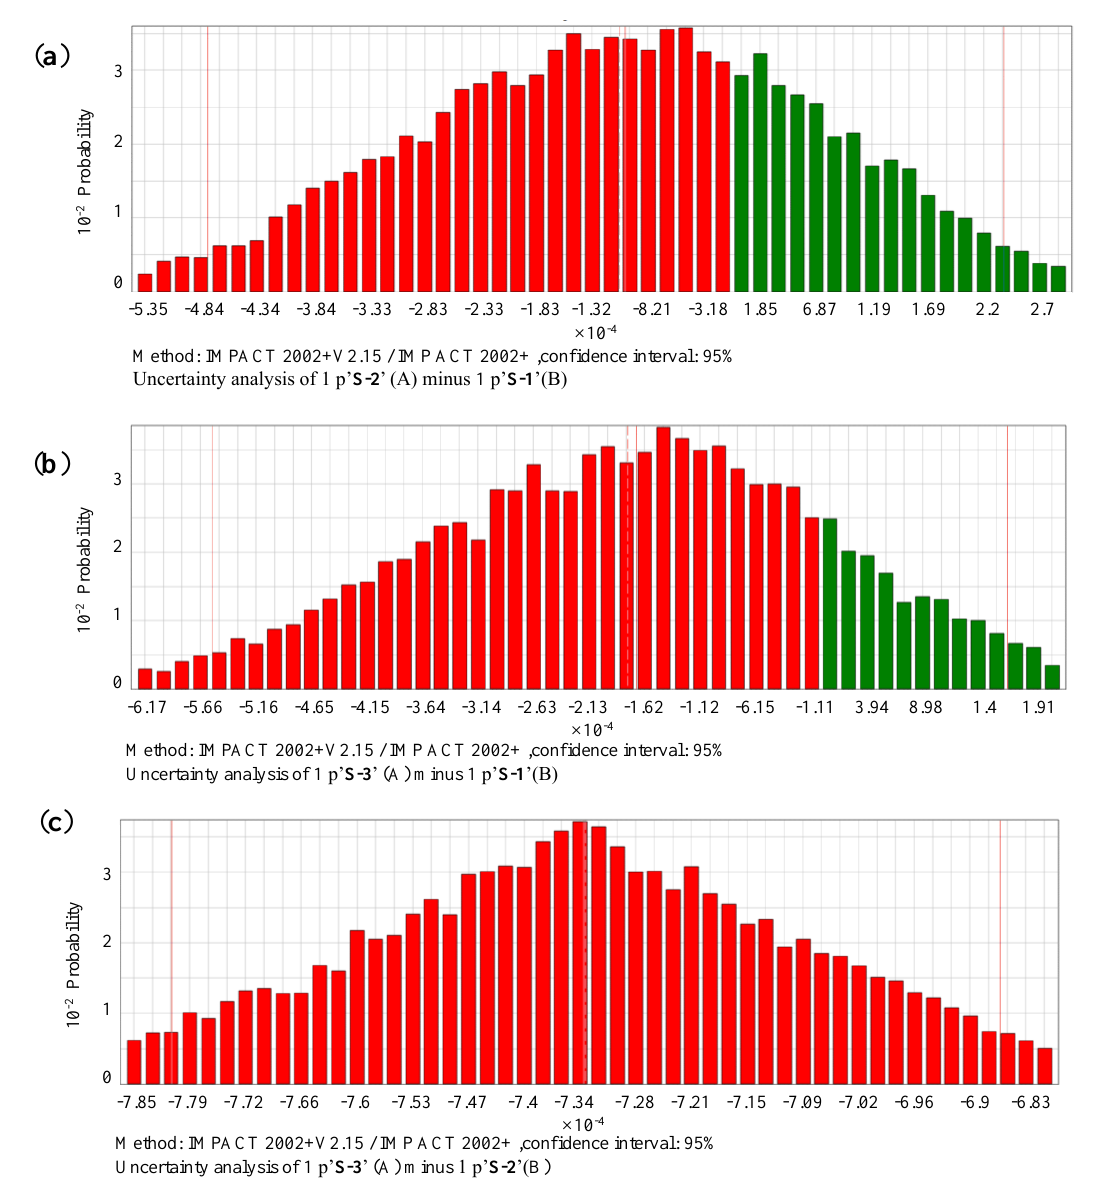
Figure 11. Probability distributions of single scored life cycle impacts in between scenarios. ( a ) comparison between S−1 vs. S−2, ( b ) comparison between S−1 vs. S−3, ( c ) comparison between S−2 vs. S−3. Notes: with confidence interval of 95%, simulated by Monte Carlo sampling, 10,000 runs; IMPACT, Impact Assessment of Chemical Toxics; S, scenario.